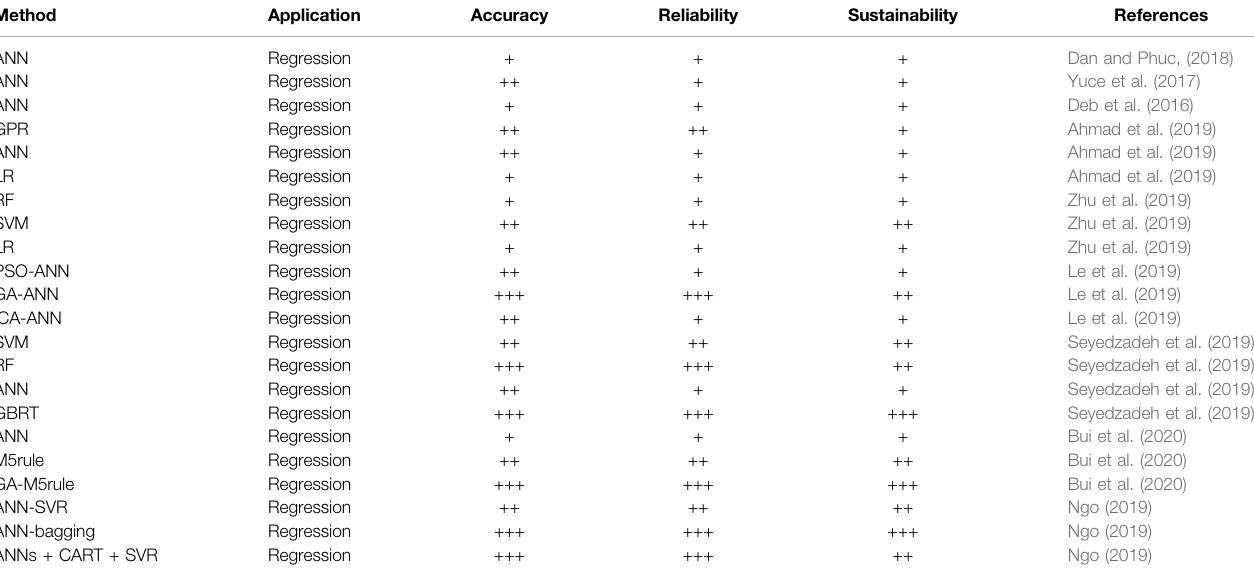
TABLE 7 | The comparison results of methods for energy load in building sectors.